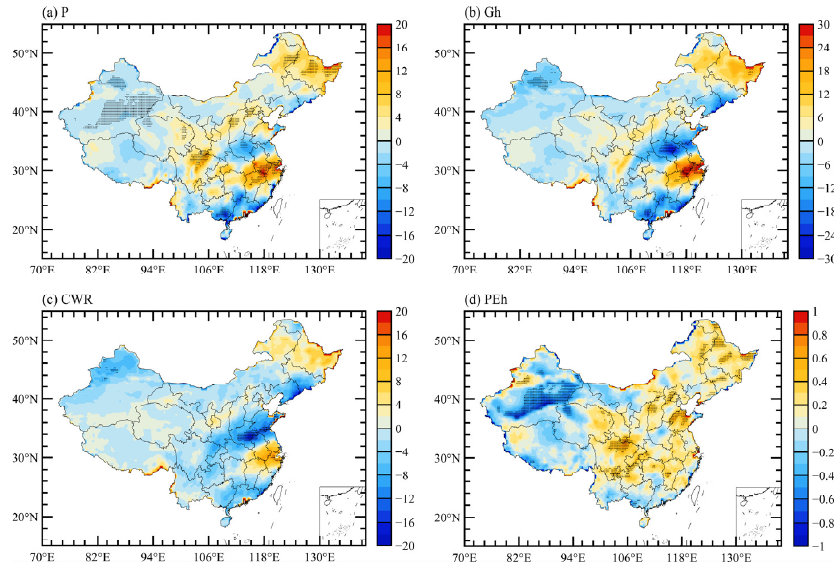
Figure 9. Spatial distribution of summer annual linear changing trends of ( a ) P (unit: mm · yr − 1 ), ( b ) Gh (unit: mm · yr − 1 ), ( c ) CWR (unit: mm · yr − 1 ) and ( d ) PEh (unit: % · yr − 1 ) in China during the summers of 2001–2020. The stippled areas indicate that the trends passed the significance test at the 95% confidence